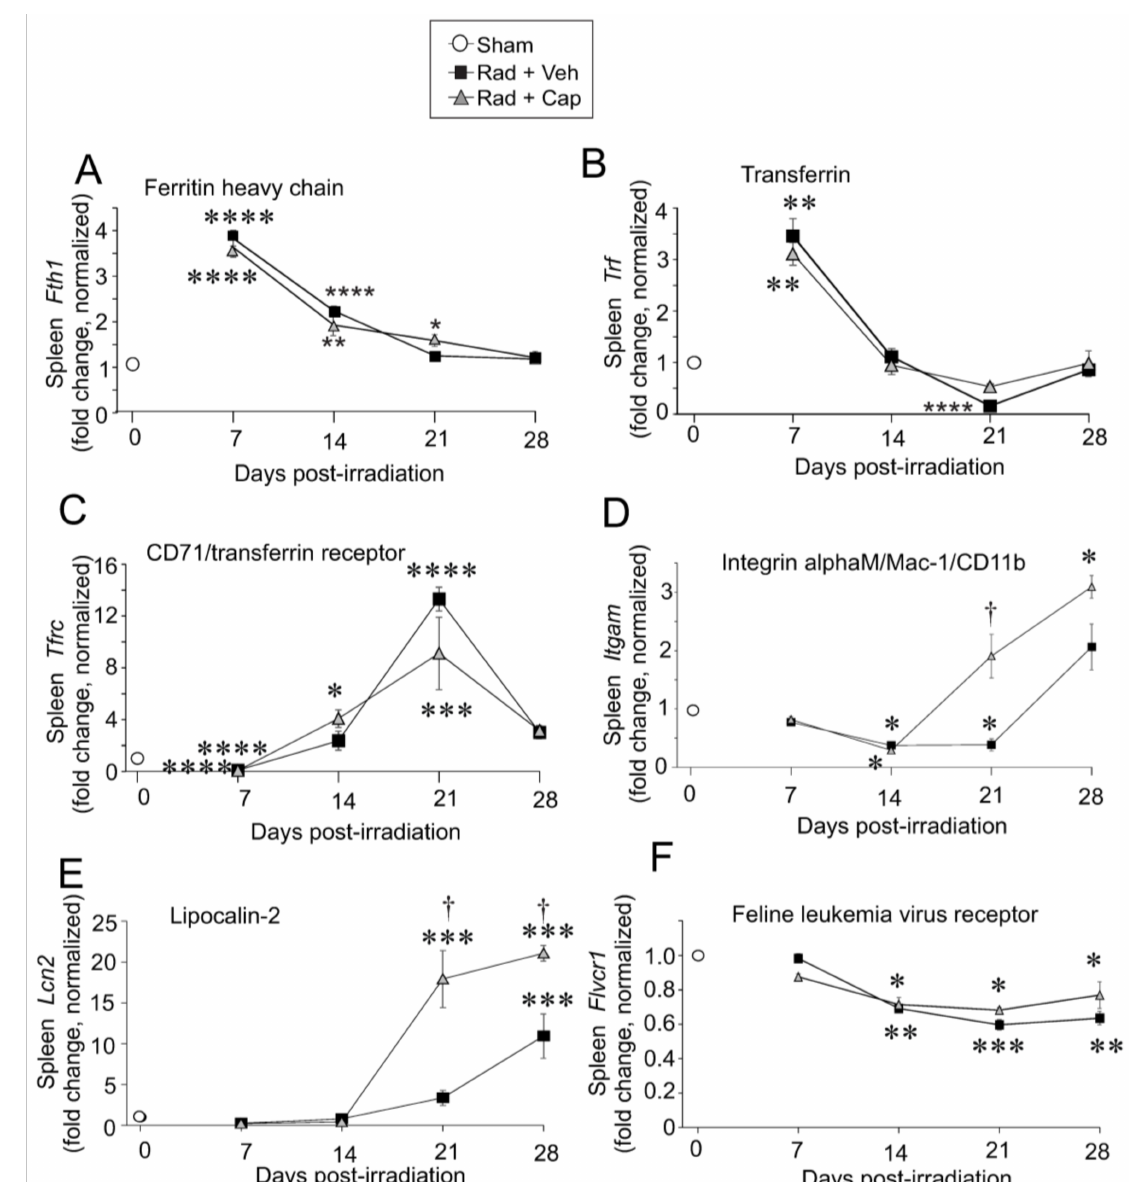
Figure 3. Total body irradiation results in increased gene expression for iron handling proteins in the spleen. C57BL/6 mice were exposed to 6.85 Gy total body irradiation. Animals received vehicle (drinking water alone) or captopril in the drinking water on days +2–+16 post-irradiation. At the indicated time points, mice were euthanized, and spleen tissue was obtained for RNA analysis. qPCR was performed for the following genes: ( A ) Fth1 (ferritin heavy chain); ( B ) Trf (transferrin); ( C ) Tfrc (CD71/transferrin receptor1); ( D ) Itgam (integrin alphaM/Mac-1); ( E ) Lcn2 (lipocalin-2); ( F ) Flvcr1 (feline leukemia virus receptor). Graphs show means ± SEM from n = 4 animals per group. Asterisks: * indicates p < 0.05 from control (sham irradiated) levels; ** indicates p < 0.01 from control; *** indicates p < 0.001 from control; and **** indicates p < 0.0001 from control. Dagger (†) indicates that the captopril-treated group value is p < 0.05 from the vehicle-treated group at the same time point. Control (sham) levels of each gene are shown as open circles at time